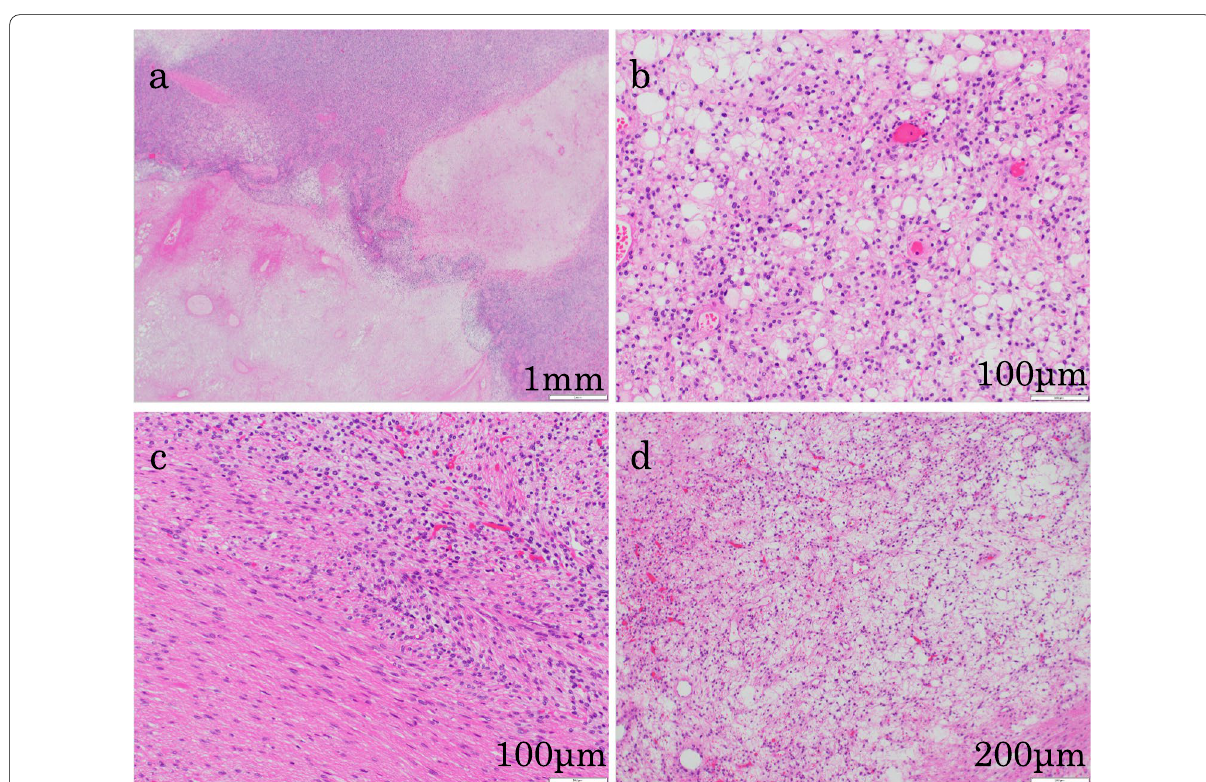
Fig. 4 Microscopic findings of the tumor. Hematoxylin and eosin staining. a Section shows a proliferation of anaplastic cells with clear cytoplasm and round heteroplasm. Map‑like necrotic foci are seen in some areas. b Some areas contain fat droplets and exhibit lipomatous features. Mitotic figures are rarely seen. c Bundled proliferation of spindle‑shaped cells is seen in some tumors. d Myxoid or microcystic changes of the stroma